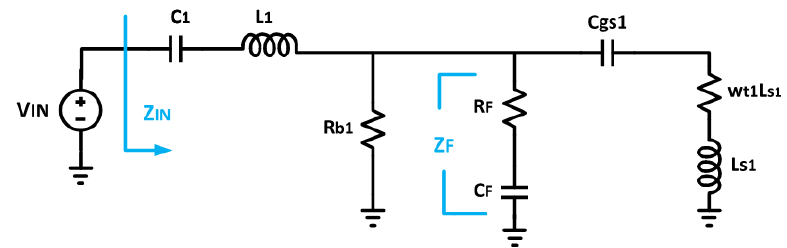
Figure 5. Input impedance equivalent circuit.